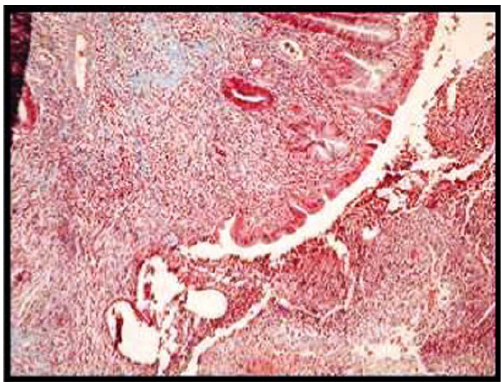
Figure 1 - A representative preparation showing the anastomotic site with some collagen deposition. No differences were detected between the groups with respect to histiocyte content, fibroblast organization, or vascularization (Masson’s